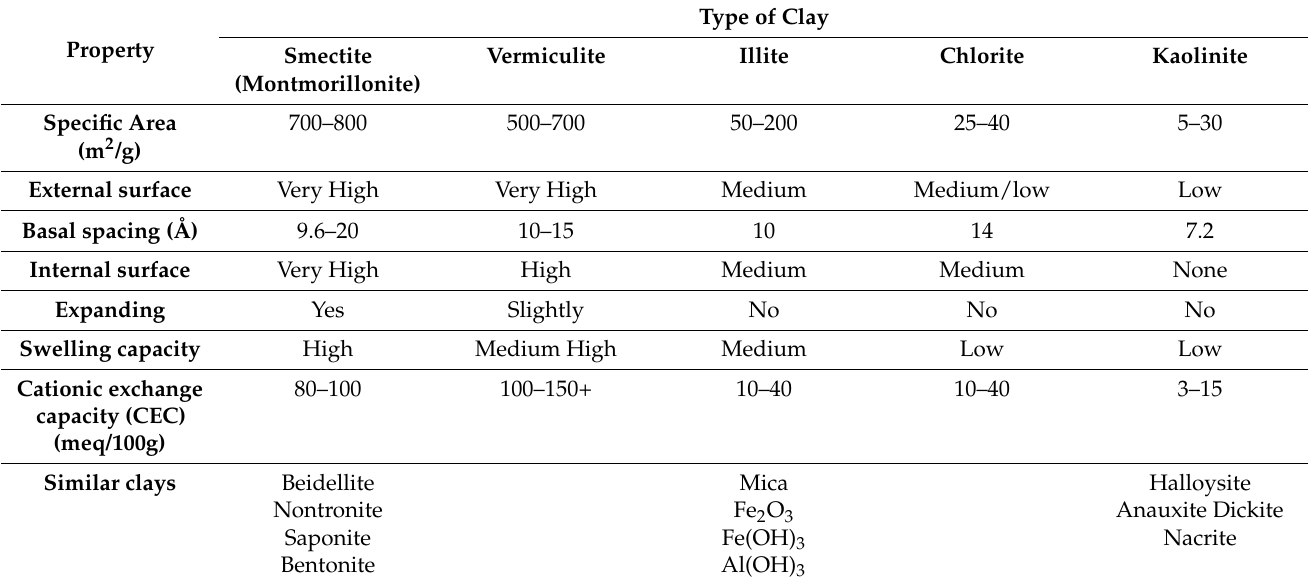
Table 5. Clay characteristics of importance (Based on